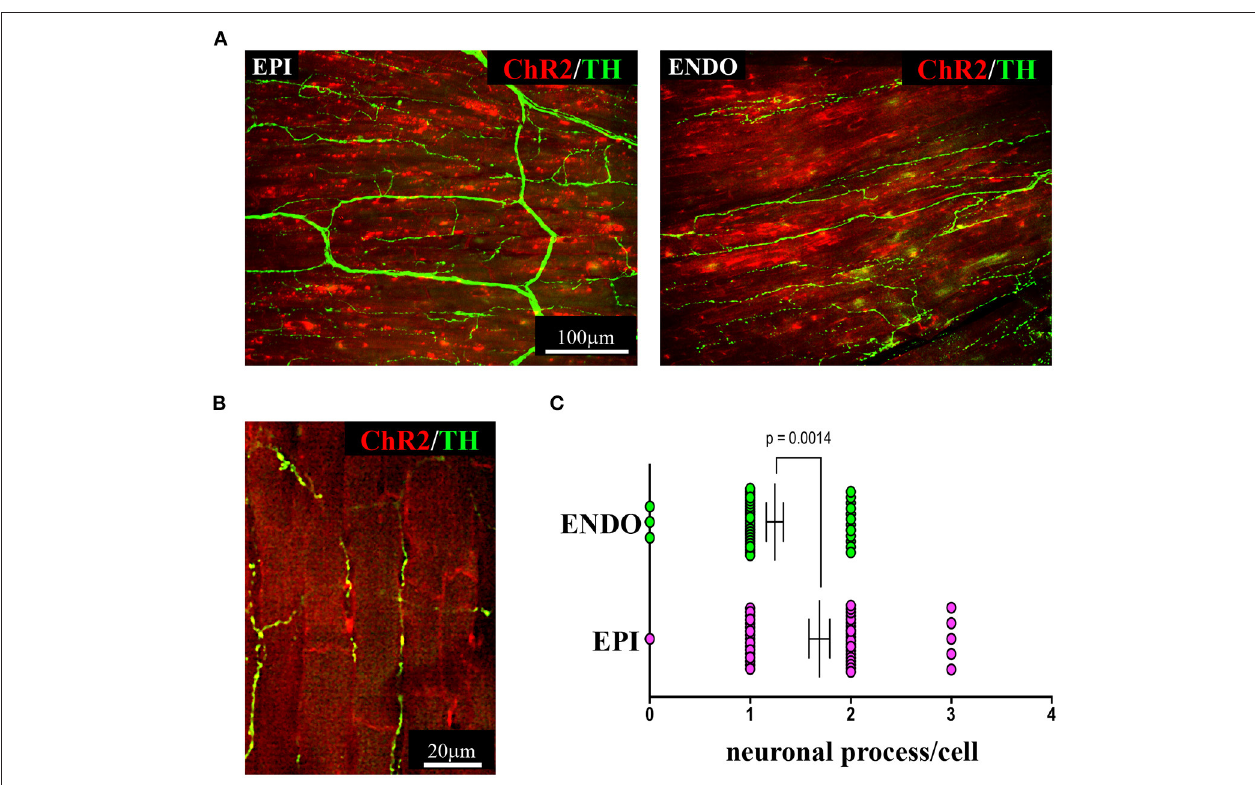
FIGURE 5 | Three-dimensional imaging of the neuronal network in the murine myocardium. (A) Maximum intensity projection of multiphoton image stacks acquired along 400 µ m in tissue clarified LV blocks from the EPI and ENDO regions of a α -MHC/ChR2- td-Tomato mouse heart, stained with an antibody to TH. Red emission of td-Tomato was used to identify CM membrane. (B) Representative single optical section of a sample processed as in (A) , resolving the neuro-cardiac interactions, and used for quantification of neuronal processes/cell in EPI and ENDO regions (C) . (A–C) Modified with permission from Pianca et al.